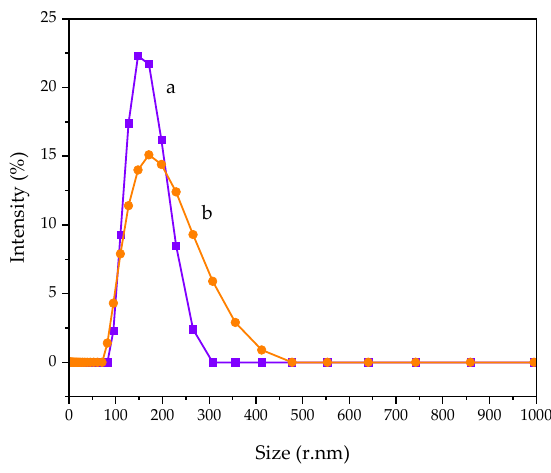
Figure 7. DLS measurements of particle size distribution of nHAp powder (a) 1DP − nHAp and (b) 2DP − nHAp.